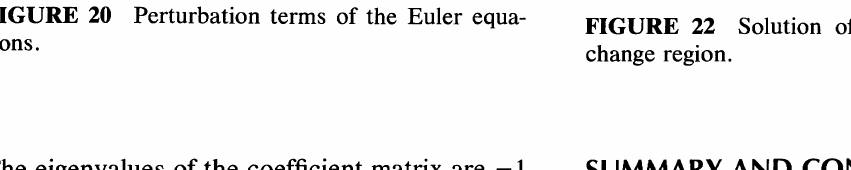
FIGURE 20 Perturbation terms of the Euler equa tions.